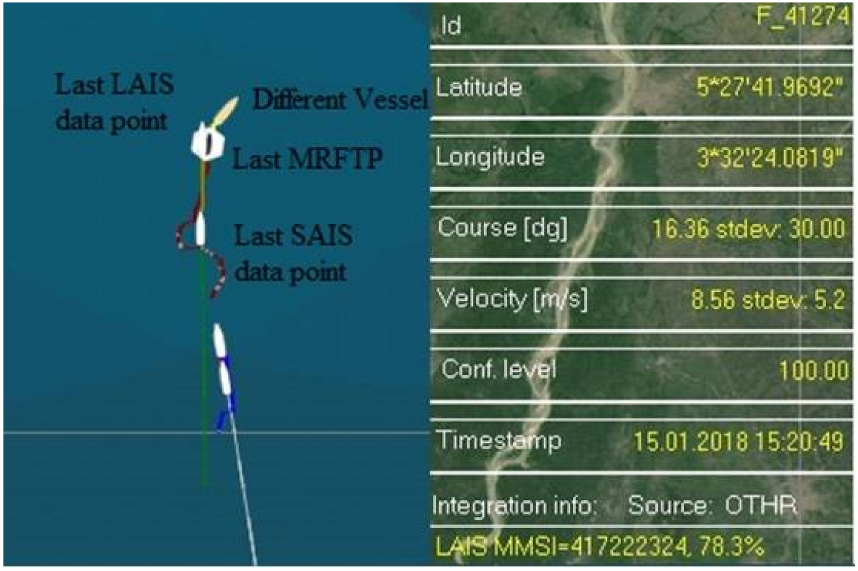
Figure 7. Resolving a complex situation—MRFT F_41274 (dark red trace: MRFT data, green trace: AIS